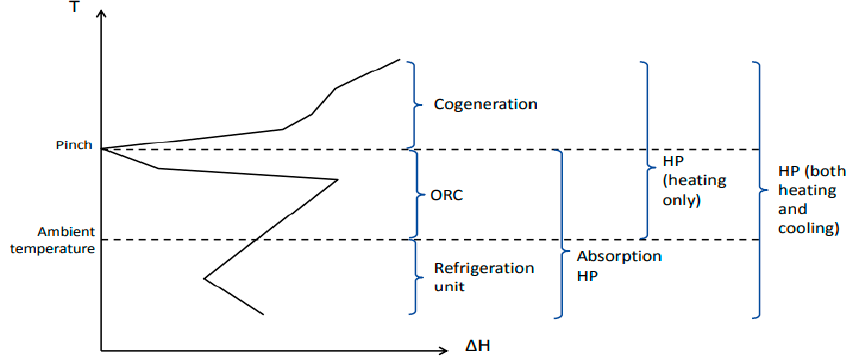
Figure 5. Zones for integrating heat conversion systems [52].